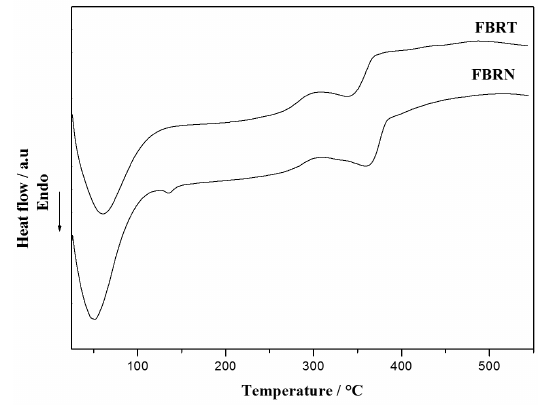
Figure 2. Differential scanning calorimetry curves.